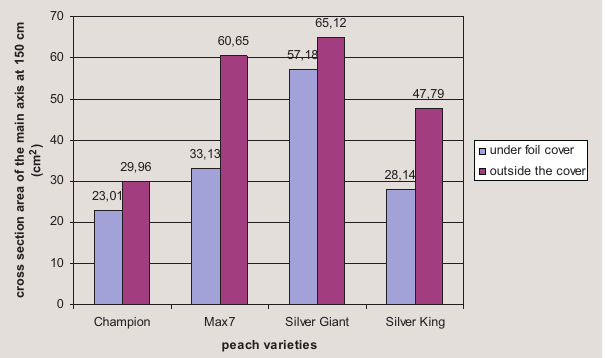
Figure 2. The cross section area of the main axis of 8 year old peach trees at